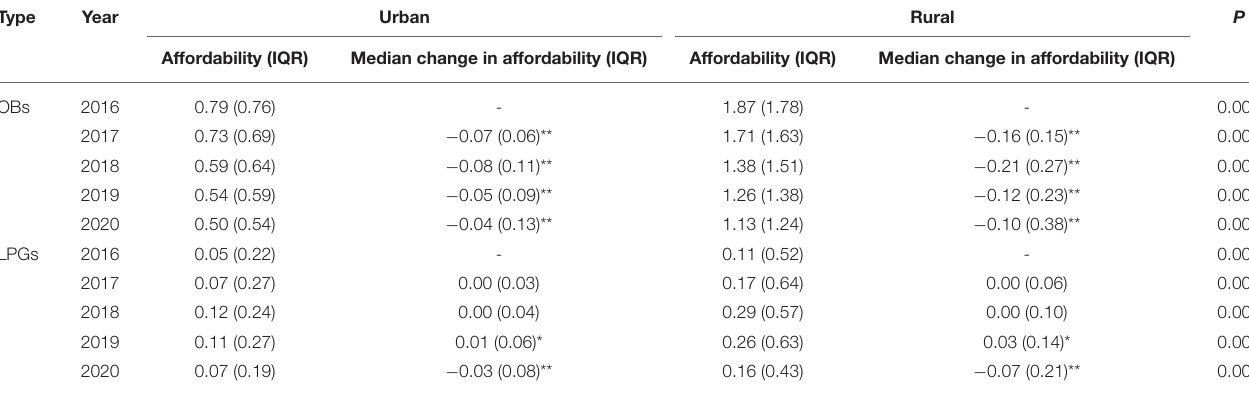
TABLE 4 | Median affordability of essential medicines in Nanjing from 2016 to